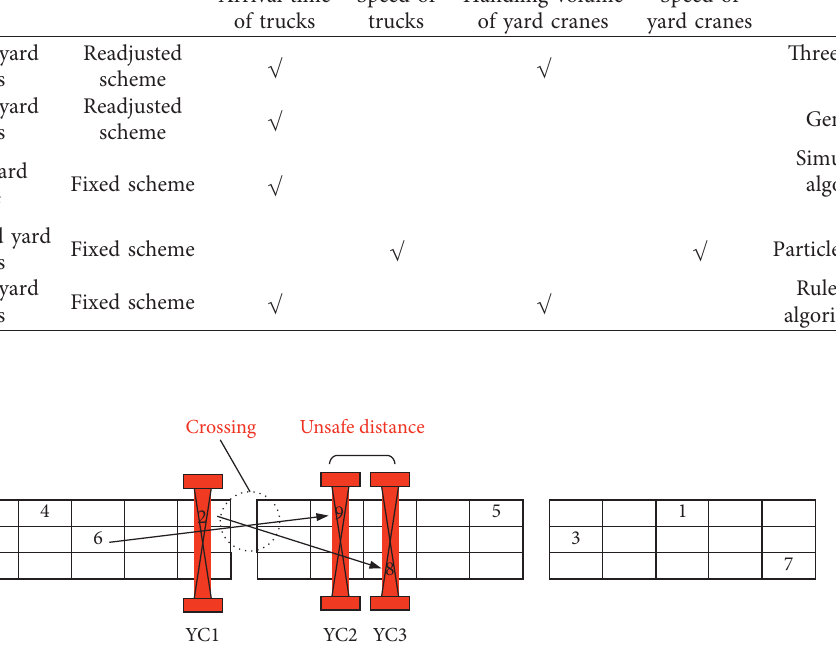
Figure 2: A sample of yard crane crossing and interference.